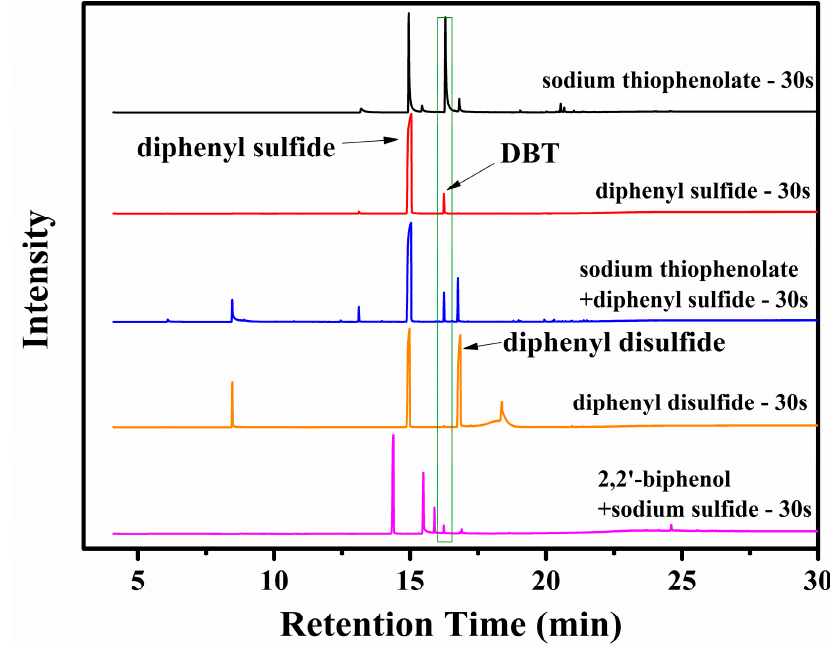
Figure 3. GC of samples thermally treated on alcohol flame.